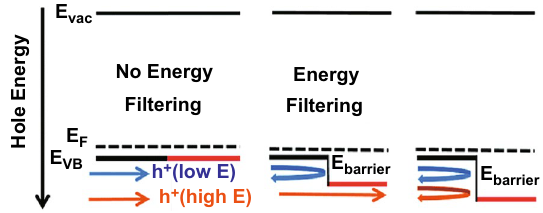
Fig. 3 An illustration of the energy filtering effect. In the middle image, carriers (holes) with high energy (red-arrow) travel unob- structed through the energy barrier while carriers with lower energy (blue) are blocked. Adapted with permission from Ref. [60]. (Color figure